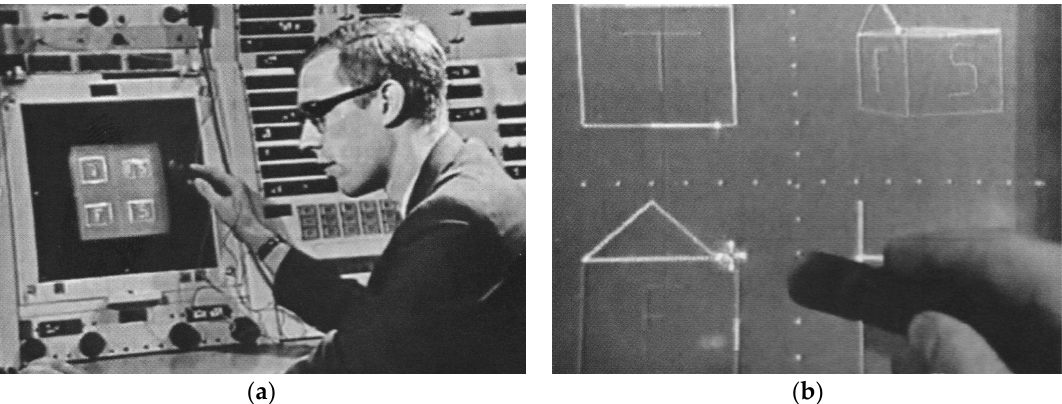
Figure 5. Johnson’s Sketchpad III : ( a ) Timothy Jonson working with Sketchpad III; ( b ) A screenshot of Sketchpad III drawing a three dimensional